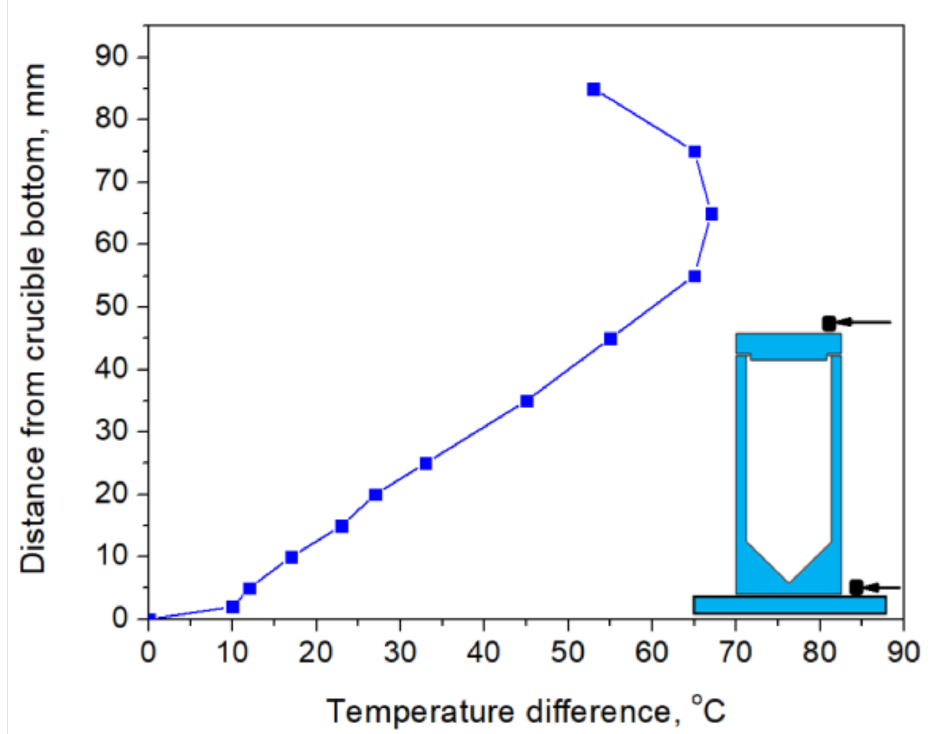
Figure 2. Axial temperature distribution in heat assembly without the crucible. The positions of Y 2 O 3 etalons for controlling melting/crystallization inside the crucible are depicted by the arrows in the inset (the crucible drawing is presented for visualization purpose; its dimensions do not correspond to the temperature distribution).